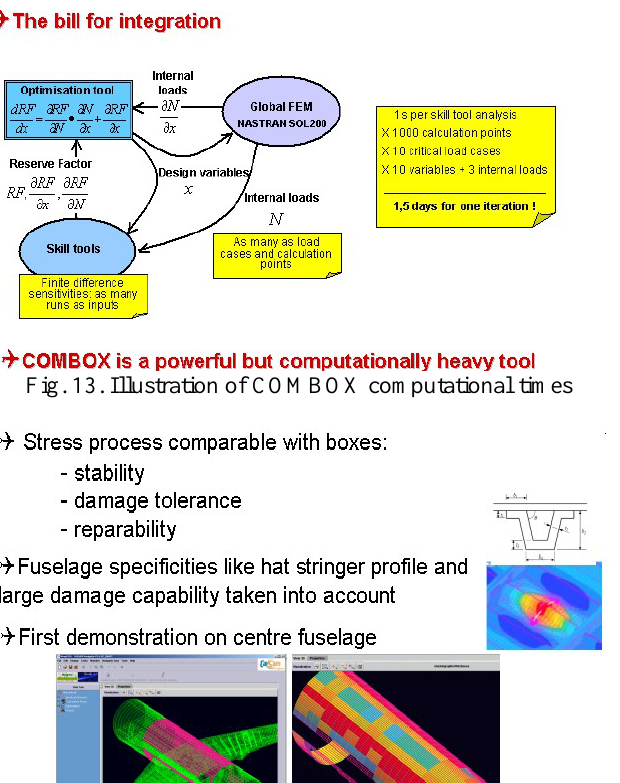
Fig. 12. Composite design & stress process inside COMBOX